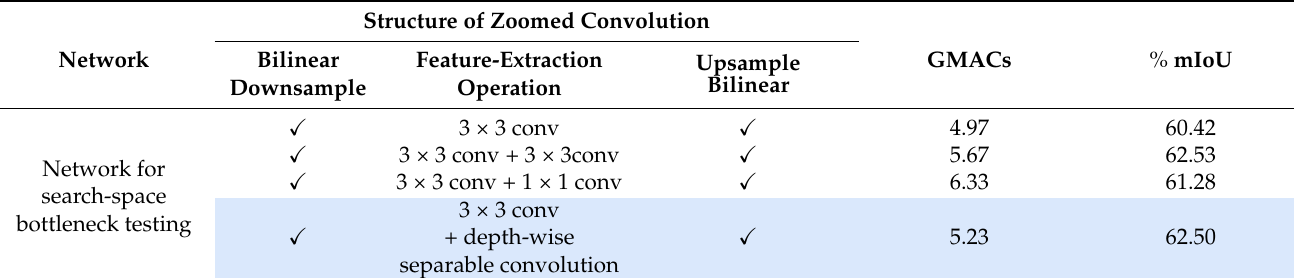
Table 4. Performance of zoomed convolution with different structures. Notation: conv denotes convolution; 3 × 3 and 1 × 1 denote kernel size.